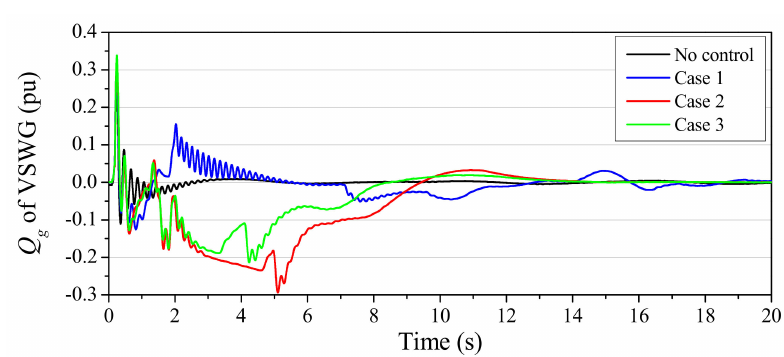
Figure 20. Active power of the VSWG (with PV system installed).